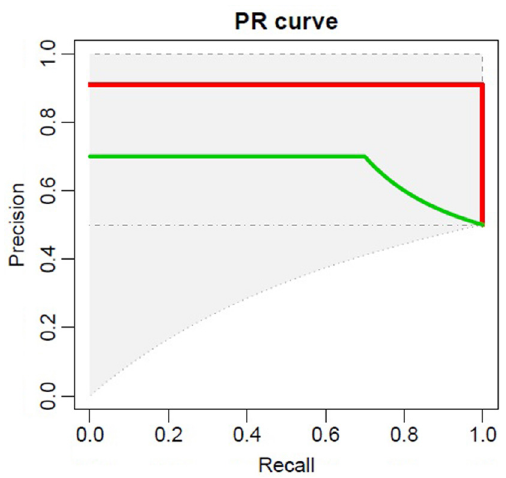
Fig. 11. The PR curves after applying the gene selection method for sample size of 20.